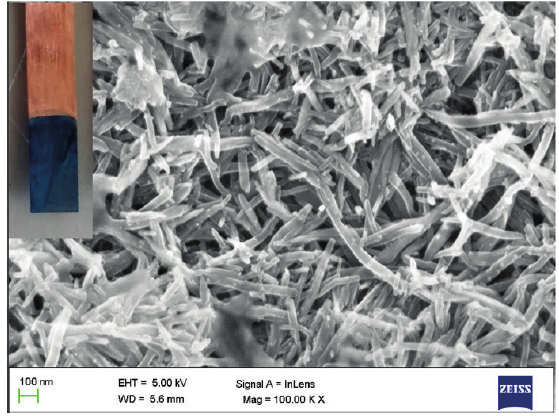
Figure 9 - Scanning electron micrograph of CuPc fi lm on the copper surface showing nanorod-like structures. The inset shows a photograph of electrodeposited CuPc fi lm on copper electrode. Reprinted with permission (Vishwanath and Kandaiah